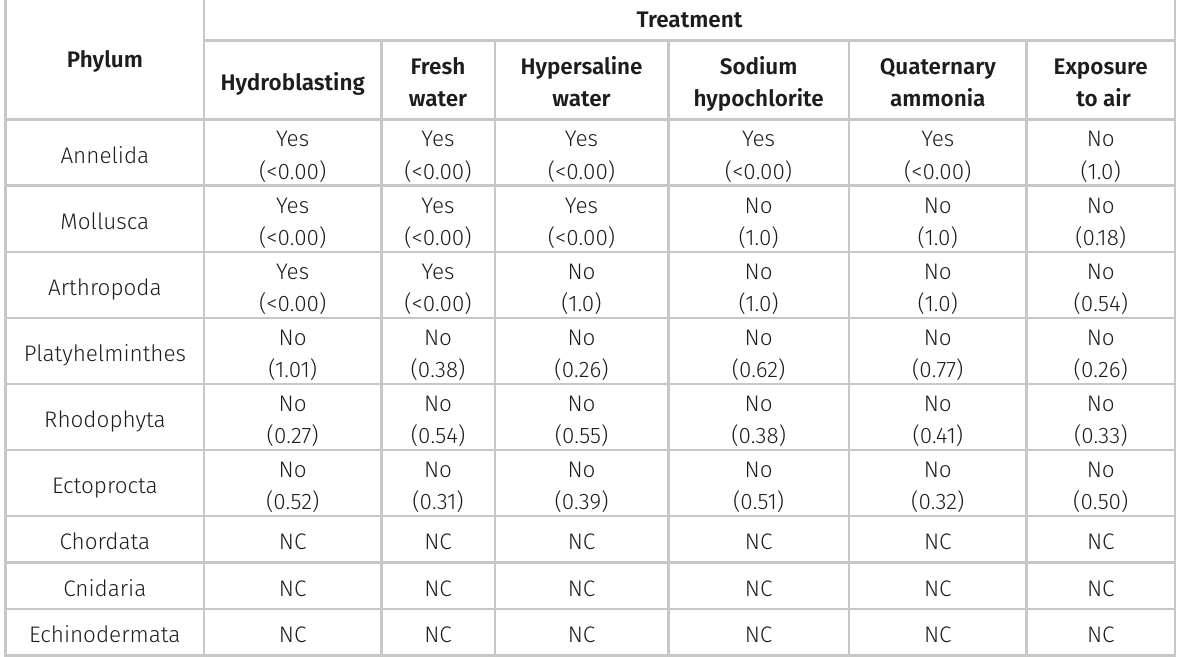
Table V. Analysis of effectiveness in the removal of different epibionts found in oyster shells compared to the control group. Yes = the existence of significant differences; No = no significant differences; NC = not comparable; α =